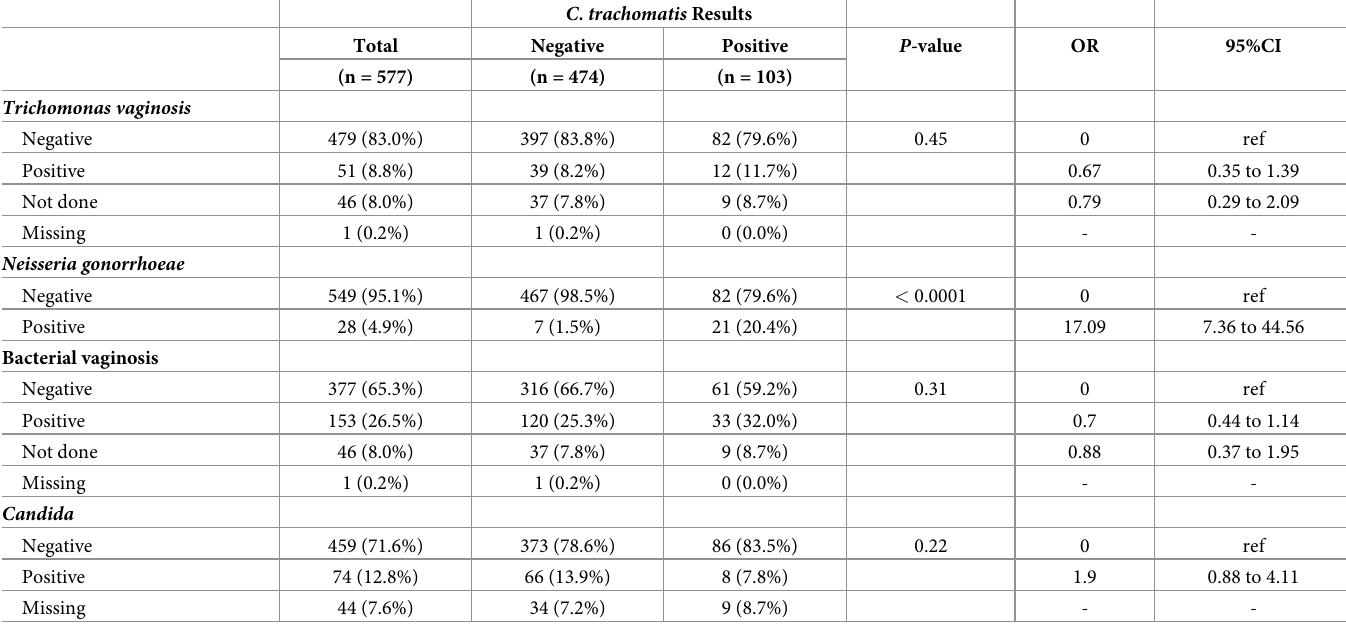
Table 2. Bivariate analyses of other STIs, bacterial vaginosis and candida associations with C. trachomatis